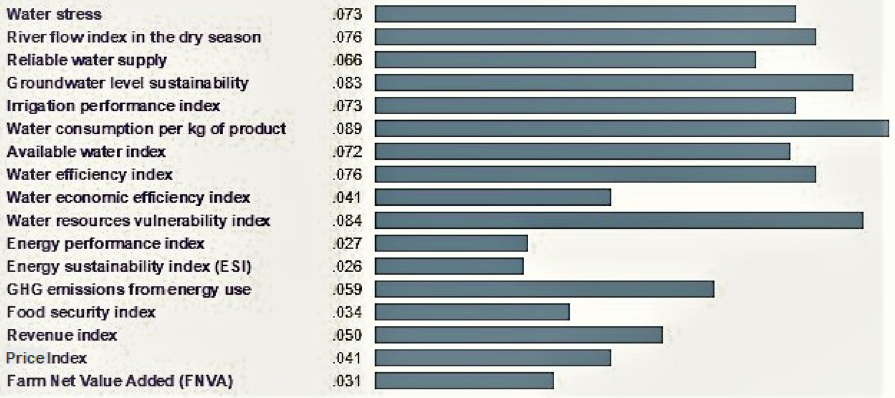
Figure 4. Comparison of